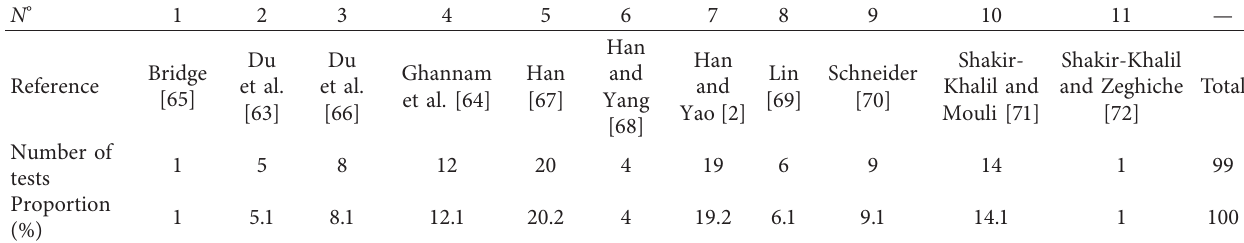
Figure 1: Diagram of concrete-filled steel tube under compression including frontal view and cross-sectional view. Table 1: Summary of the dataset used in this study.